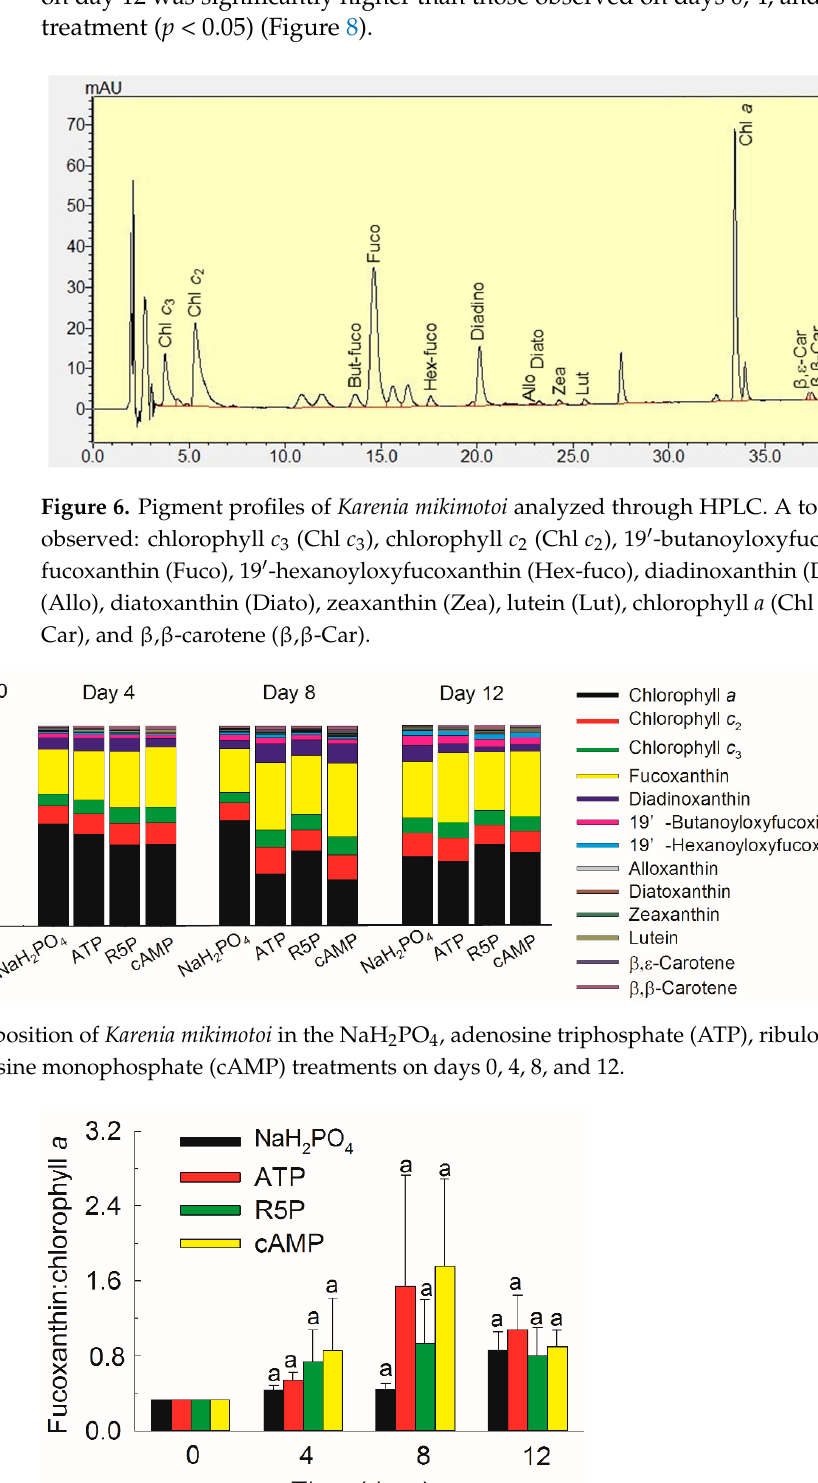
Figure 8. Ratio of fucoxanthin:chlorophyll a in the NaH 2 PO 4 , adenosine triphosphate (ATP), ribulose 5-phosphate (R5P), and cyclic adenosine monophosphate (cAMP) treatments on days 0, 4, 8, and 12. The values are the mean ± S.D. ( n = 3).